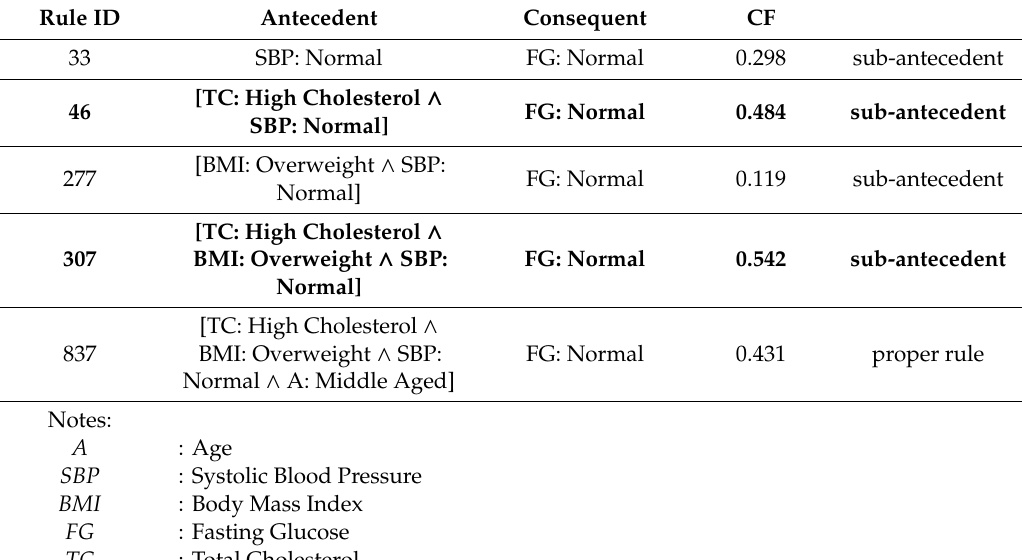
Table 6. Example of subsumption rules (proper rule and its sub-antecedents) (2).